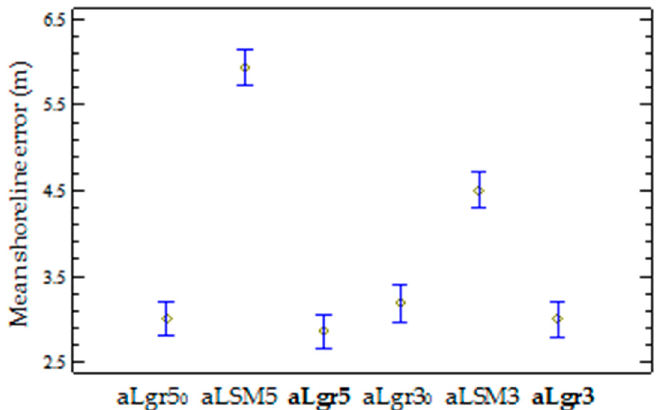
Figure 9. Mean-value chart with the Fisher LSD intervals at the 95% confidence level in Fisher’s test. The sub-pixel shoreline errors shown correspond to the aLgr 0 (prior to the smoothening step), aLSM solutions, and aLgr (which is highlighted in bold for being the proposed methodology) by using a third or a fifth-degree in the polynomial solution. These latter solutions are mapped in Figure 7 for a specific